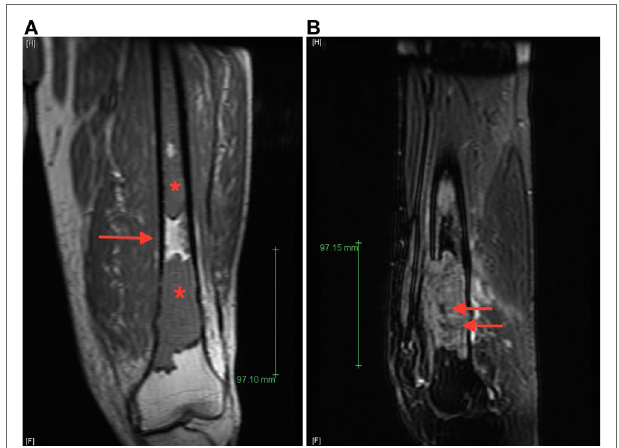
FIgURe 2 | (a) Coronal T 1 magnetic resonance imaging (MRI) image of the left femur demonstrates T 1 hypointense lesions (starts) with normal intervening bone marrow (arrow), (B) sagittal T 2 fat­saturated MRI image of the dominant distal femur lesion demonstrated intermediate T 2 hyperintensity with areas of marked low signal intensity centrally (arrows), suggestive of areas of sclerosis not appreciated radiographically.